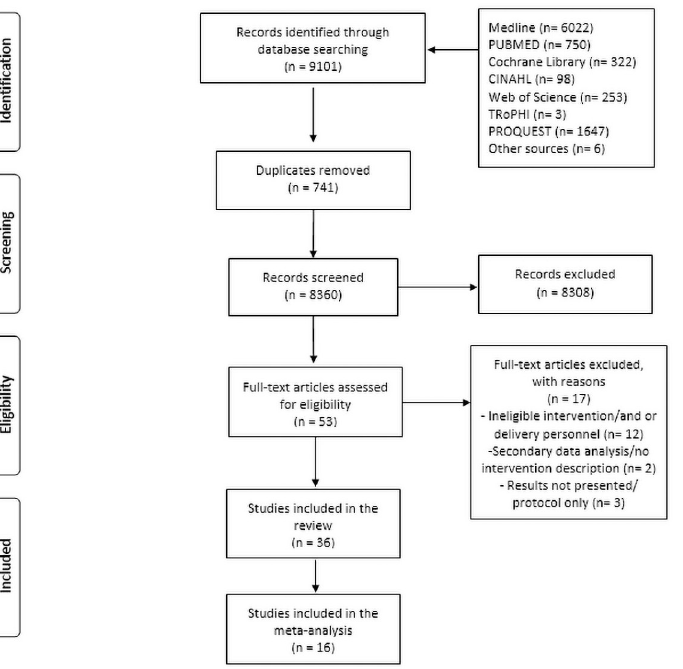
Fig 1. PRISMA flowchart of study selection